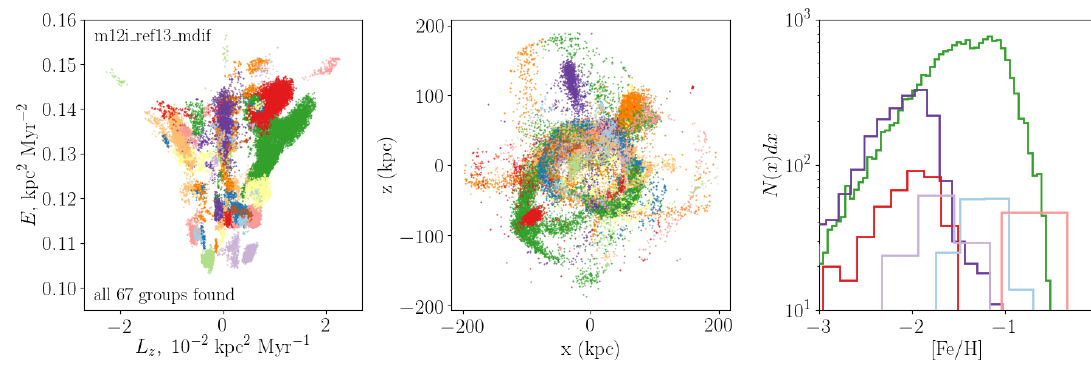
Figure 5. Left : groups found by EnLink group finder [37] in the space of constants of motion for star particles with 50 < d < 300 kpc in a high-resolution simulated Milky Way ( m p = 7070 M (cid:12) ) from the Latte suite, including a more realistic model for the turbulent diffusion of chemical elements [39] that results in more plausible abundance distributions. Different groups are plotted in different colors. Center : the same groups shown in Cartesian coordinates (with origin at the center of the main simulated galaxy) show the features of tidal streams. Right : a selection of 5 groups shows the variety of different distributions in iron abundance among the different building blocks of the stellar